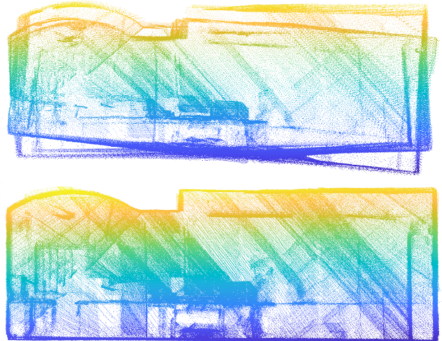
Figure 1. Point cloud as a result of a mobile mapping in an indoor environment. Due to the use of a line scanning device and non-uniform movements of the mobile mapping platform, the points are inhomogeneously sampled. The color of each point illustrates its height. Top: Inaccurate guess of the extrinsic calibration parameters. Bottom: Calibrated using the Robust Automatic Detection in Laser Of Calibration Chessboards (RADLOCC) [1–3], which is a target calibration approach for cameras and laser